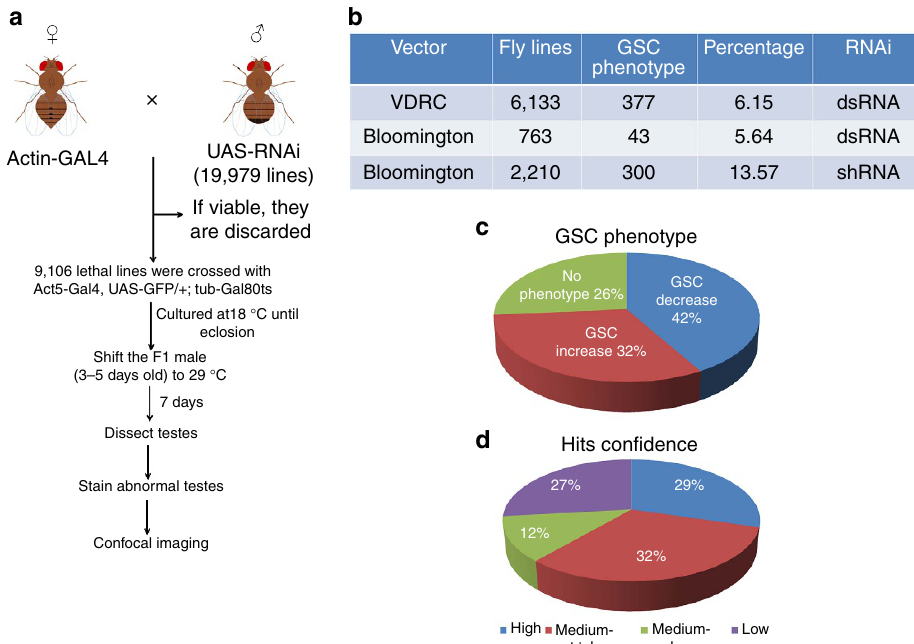
Figure 1 | Transgenic RNAi screen. ( a ) Workflow of the GSC RNAi screen. ( b ) Pie chart summarizing the screen results. Fly lines shown in the table are those that gave a lethal phenotype when crossed with Act-Gal4 . ( c ) Pie chart summarizing phenotype observed in all the 720 lines. Act ts 4 RNAi male flies were dissected after 7 days at 29 (cid:2) C. Their testes were stained with antibodies (vasa, 1B1 and Arm) and analysed by confocal microscopy. The phenotypes were divided into two major categories (GSC decrease and increase). Percentage of fly lines showing no phenotypes are also shown in the chart. ( d ) Confidence of 530 genes identified from the screen. High-confidence genes were identified by two or more independent RNAi lines. Medium-high- confidence genes were identified by one RNAi line, but they shared a complex with high-confidence hits. Medium-low-confidence genes were identified by one RNAi line, but they shared a complex with other low-confidence hits. Low-confidence hits were identified by one RNAi